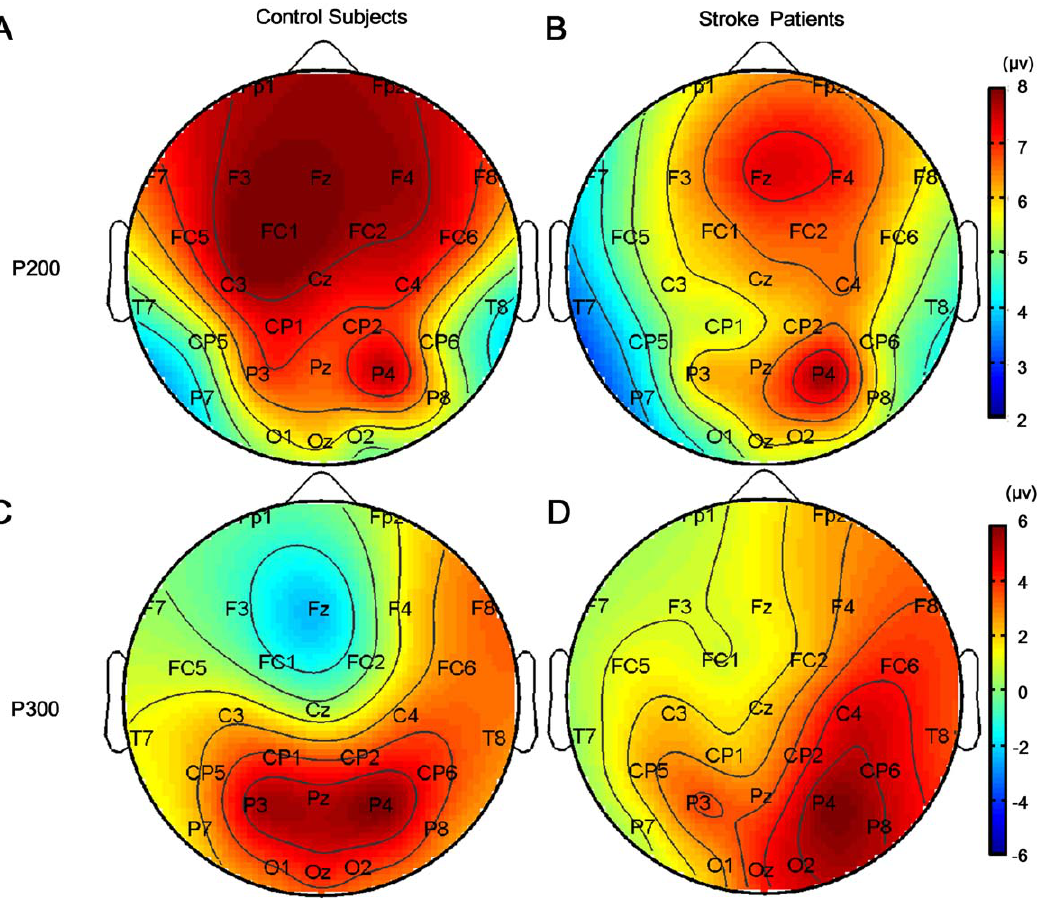
Figure 4. Brain mappings of ERP. A and C: Brain mappings of P200 and P300 for control subjects were shown respectively. B and D: Brain mappings of P200 and P300 for stroke patients were illustrated. In the brain mappings of ERP, more red color represented higher phase-locked activation. doi:10.1371/journal.pone.0042922.g004 illustrated that the phase-locked activation during mentally rotating of left and right hand stimulus was comparable. The ANGLE factor was significant (F(5,100)= 2.390, p =0.043), i.e., P300 amplitudes for different angles were significantly different. The ANGLE 6 GROUP interaction was also significant (F(5,100)= 3.319, p = 0.008). Follow-up tests showed that P300 amplitude in control group decreased as the angle increased from upright position (0 u ) to 180 u , indicating significant mental rotation phenomena (p , 0.002), which was called ‘‘amplitude modulation effect’’ (Figure 3A). However, such an effect was not observed in stroke patients (p . 0.058) (Figure 3C). The significant effect of REGION and its interaction with GROUP (REGION: F(12,240) =8.071, p , 0.001; REGION 6 GROUP: F(12,240) =9.789, p , 0.001) were due to the fact that phase- locked brain activation for stroke patients was significantly different from control subjects. Significant P300 activation was observed in parietal lobes in both hemispheres (P3, Pz and P4) for control subjects (Figure 4C), which was observed only in the right parietal lobe (P4, P8 and CP6) in contralesional hemisphere for stroke patients, indicating significant ‘‘lateralization’’ effect of P300 (Figure 4D). In short, hypoactive phase-locked activation in ipsilesional parietal lobe possibly implied the impaired cognitive process of spatial information processing and mental rotation for stroke patients.